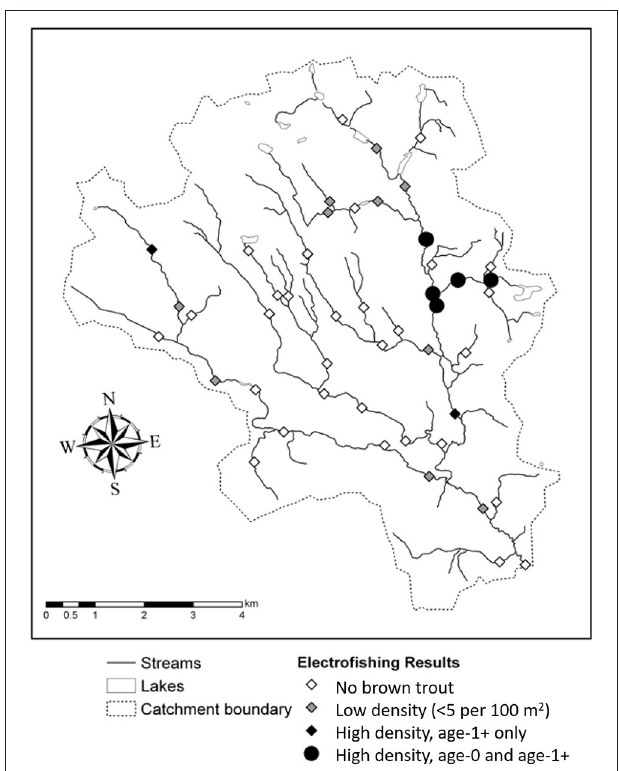
FIGURE 3 | Observed distribution of brown trout at the time of electrofishing (September